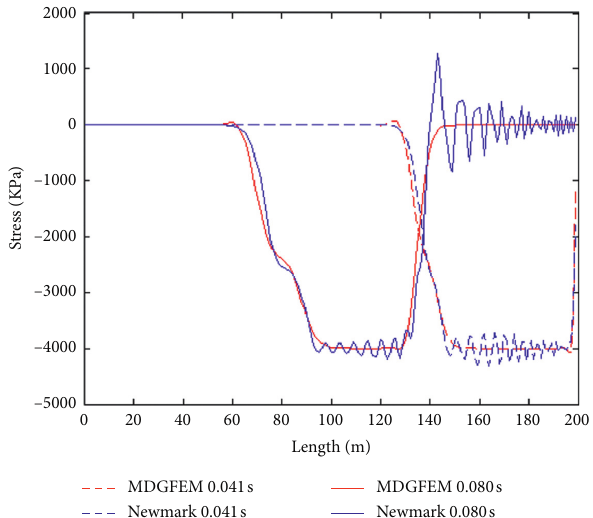
Figure 4: Elastic-plastic stress profiles of different methods at t � 0.041 s and t � 0.08s.